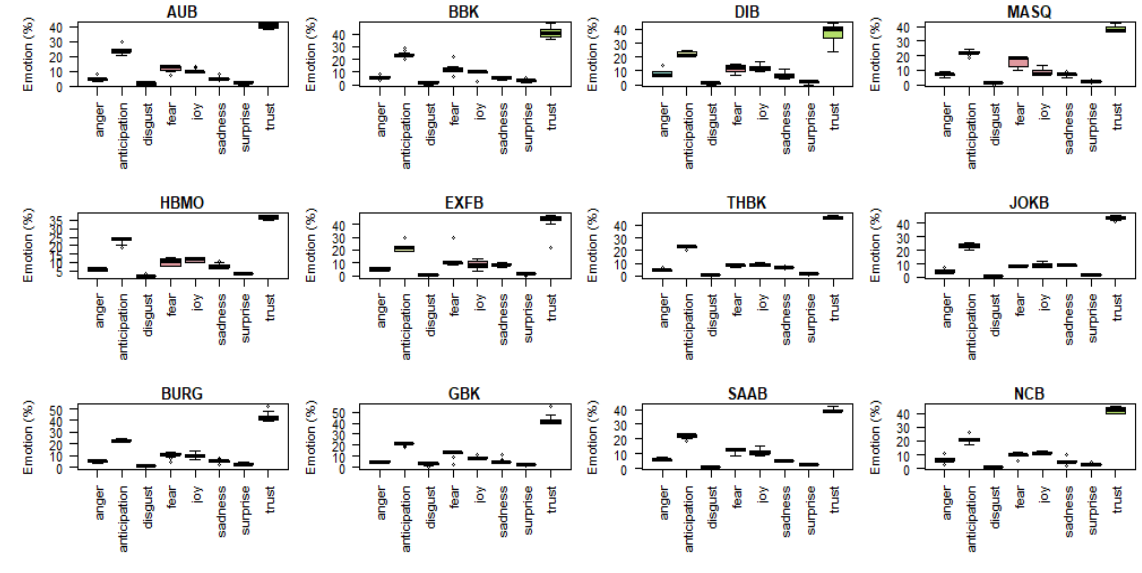
Figure 2. The boxplot for each emotional category in banks’ annual reports (from 2002 to 2017)